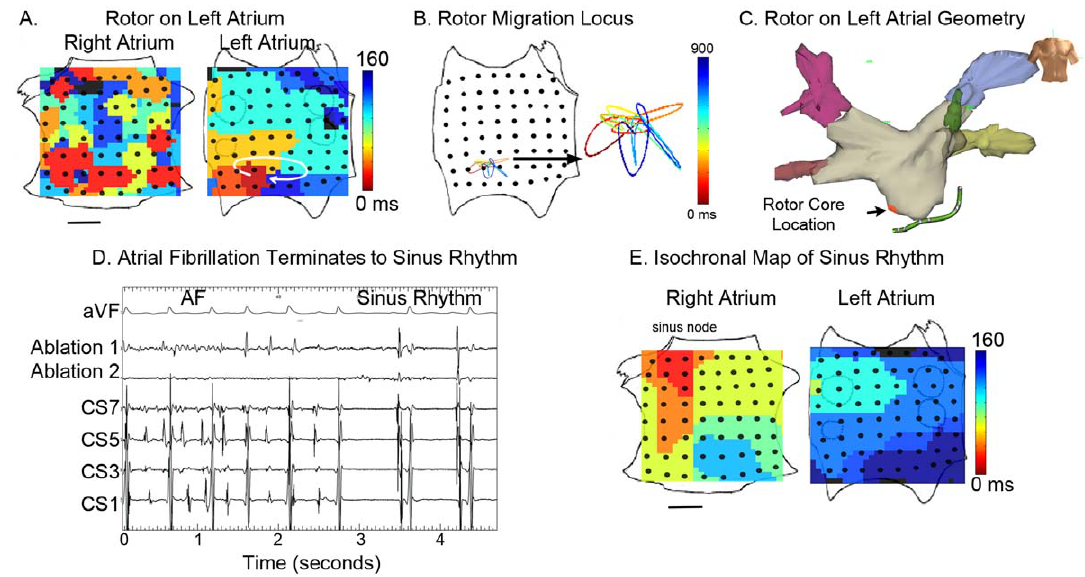
Figure 3. AF termination by ablation of Stable LA rotor. A . Left atrial rotor during paroxysmal AF visualized using isochrones. B . Migration locus of the rotational center, color-coded over time. C . Ablation lesions at rotor in low left atrium, applied 1 hour after initial recording of the rotor, shown on patient specific geometry. Red lesion is where AF terminated, and 3 other lesions (gray) were also applied. D . Electrode recordings during AF with termination to sinus rhythm by , 1 minute ablation at the rotational center (ECG lead aVF, and electrodes at ablation catheter, coronary sinus). E . Isochronal map of sinus rhythm. The patient remains free of AF on implanted cardiac monitor at 9 months. Scale Bar 1 cm.